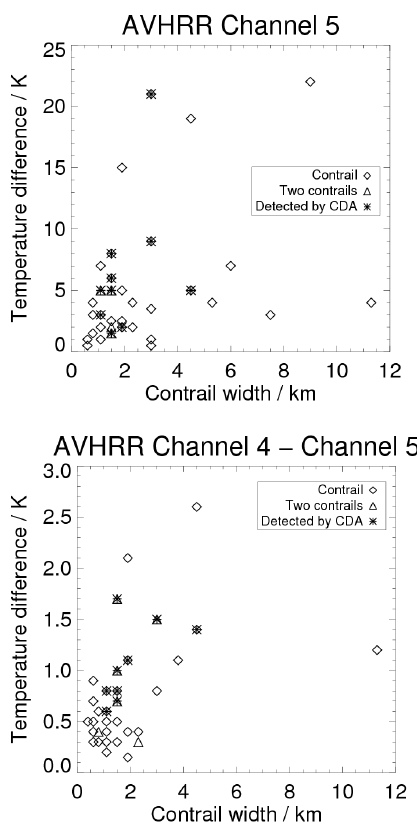
Fig. 7. Relationship between contrails and their surroundings de- rived from AVHRR data as a function of contrail width as obtained from Wolkam data. Top: Relationship of contrail width and bright- ness temperature difference between the contrail and its surround- ings in AVHRR channel 5. Bottom: Relationship of contrail width and brightness temperature difference between the contrail and its surroundings in the temperature difference image (channel 4–5). In both graphics diamonds ( ♦ ) mark single contrails detected in AVHRR data, triangles ( 4 ) indicate 2 contrails each, an asterisk ( ∗ ) at the centre marks the successful detection of the contrail by the